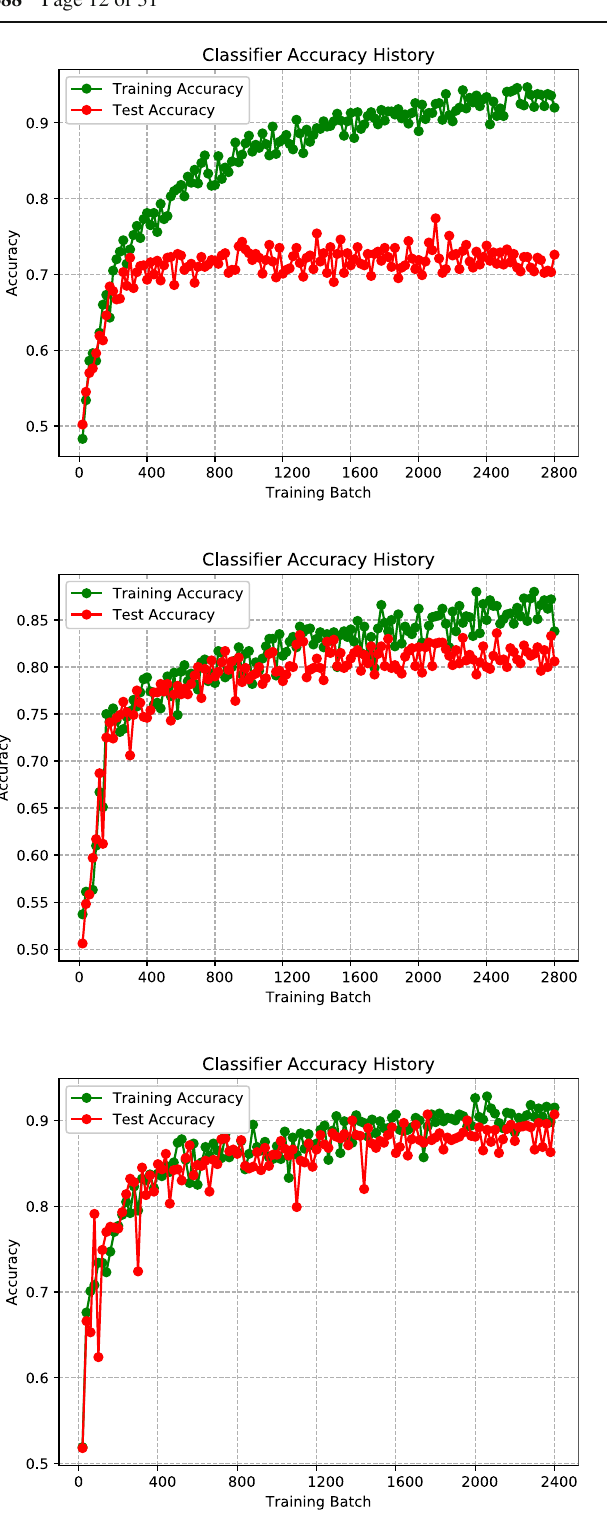
Fig. 12 Training curves for best DNN (top), CNN (middle), and GoogLeNet (bottom) hyperparameters, trained on variable-angle γ / π 0 samples. We see that the DNN over-trains quickly and saturates at a relatively low accuracy, while the CNN takes longer to over-train and reaches a higher accuracy, and GoogLeNet performs best of all. Each 400 batches corresponds to a single epoch